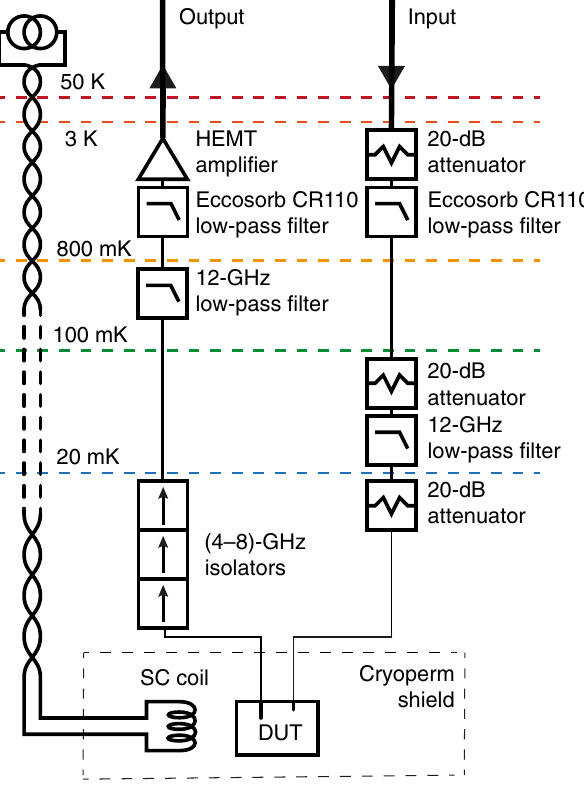
FIG. 5. Cryogenic experimental